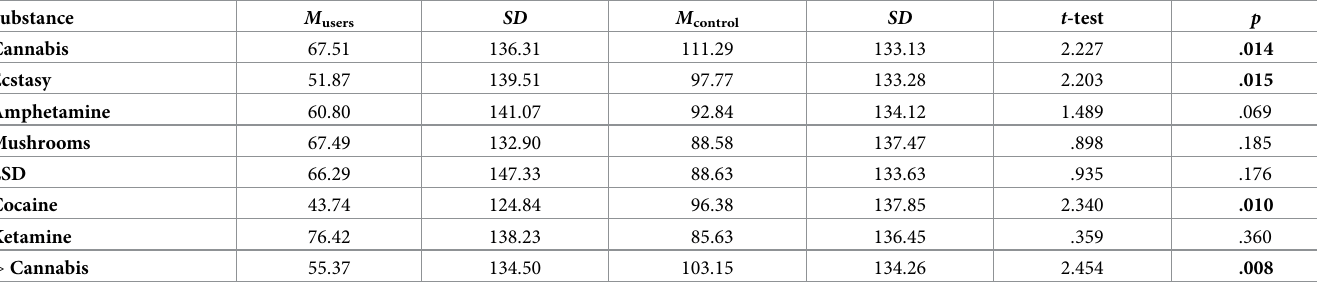
Table 6. Differences in sense of agency (overall binding) between drug users and controls.